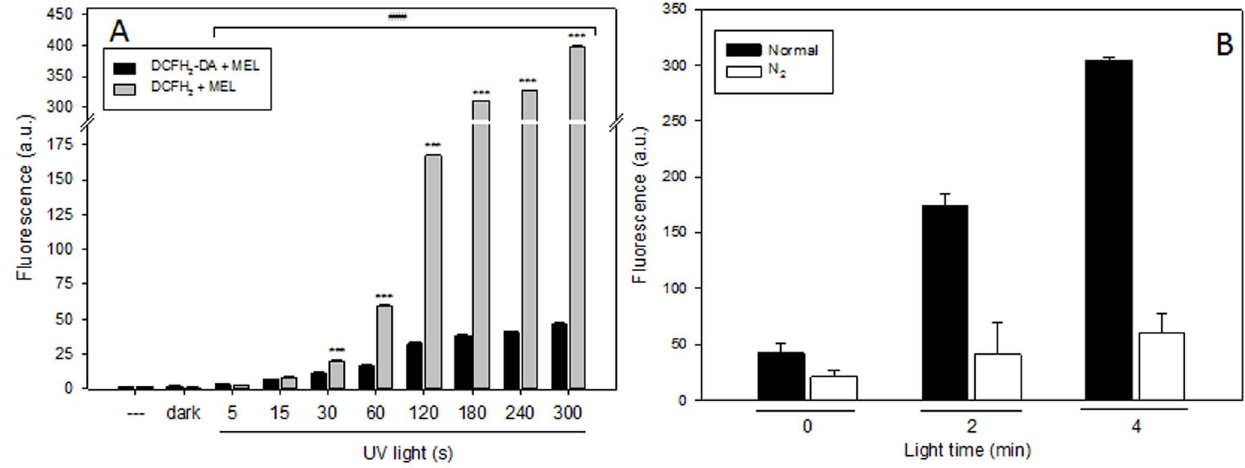
Figure 3. Role of UV light and O 2 in DCFH 2 -DA and DCFH 2 photooxidation. A) Fluorescence of DCFH 2 (10 m M) or DCFH 2 -DA (100 m M) plus MEL (1 mM) under UV light. B) Fluorescence of DCFH 2 (10 m M) plus MEL (1 mM) under N 2 or normal